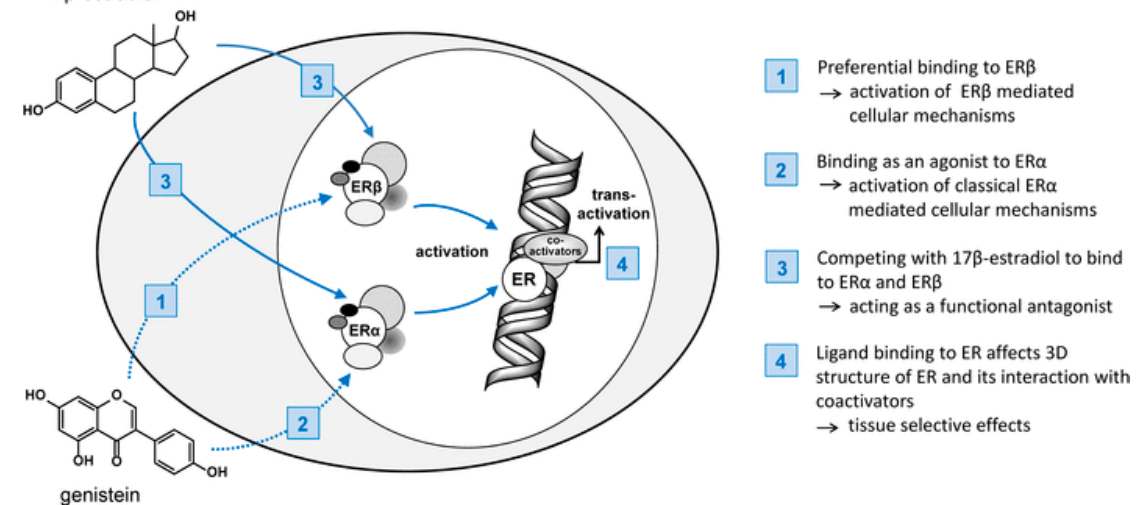
Figure 4. Mechanism of action of 17 β -estradiol and potential interaction of isoflavones in the cascade. ER, estrogen receptor; SERM, selective estrogen receptor modulator [11].